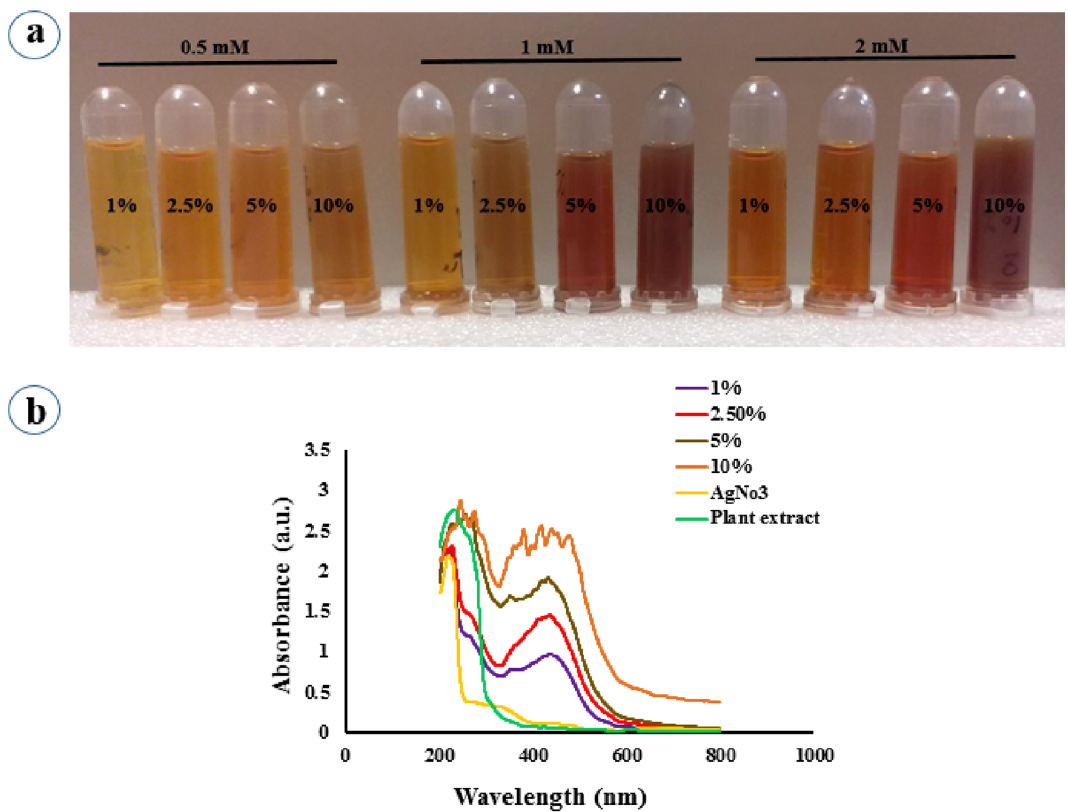
Figure 1. Characterization of Pf-AgNPs. ( a ) Visual observation of different color patterns and the reduction of Ag + to Ag 0 using the various concentration of aqueous leaf extract of Perilla frutescens and AgNO 3 during 90 min. ( b ) UV–Visible spectroscopic analysis of AgNO 3 (2 mM) alone and along with various concentration of the extract of P. frutescens (1, 2.5, 5, and 10%, v/v), and the extract of P. frutescens